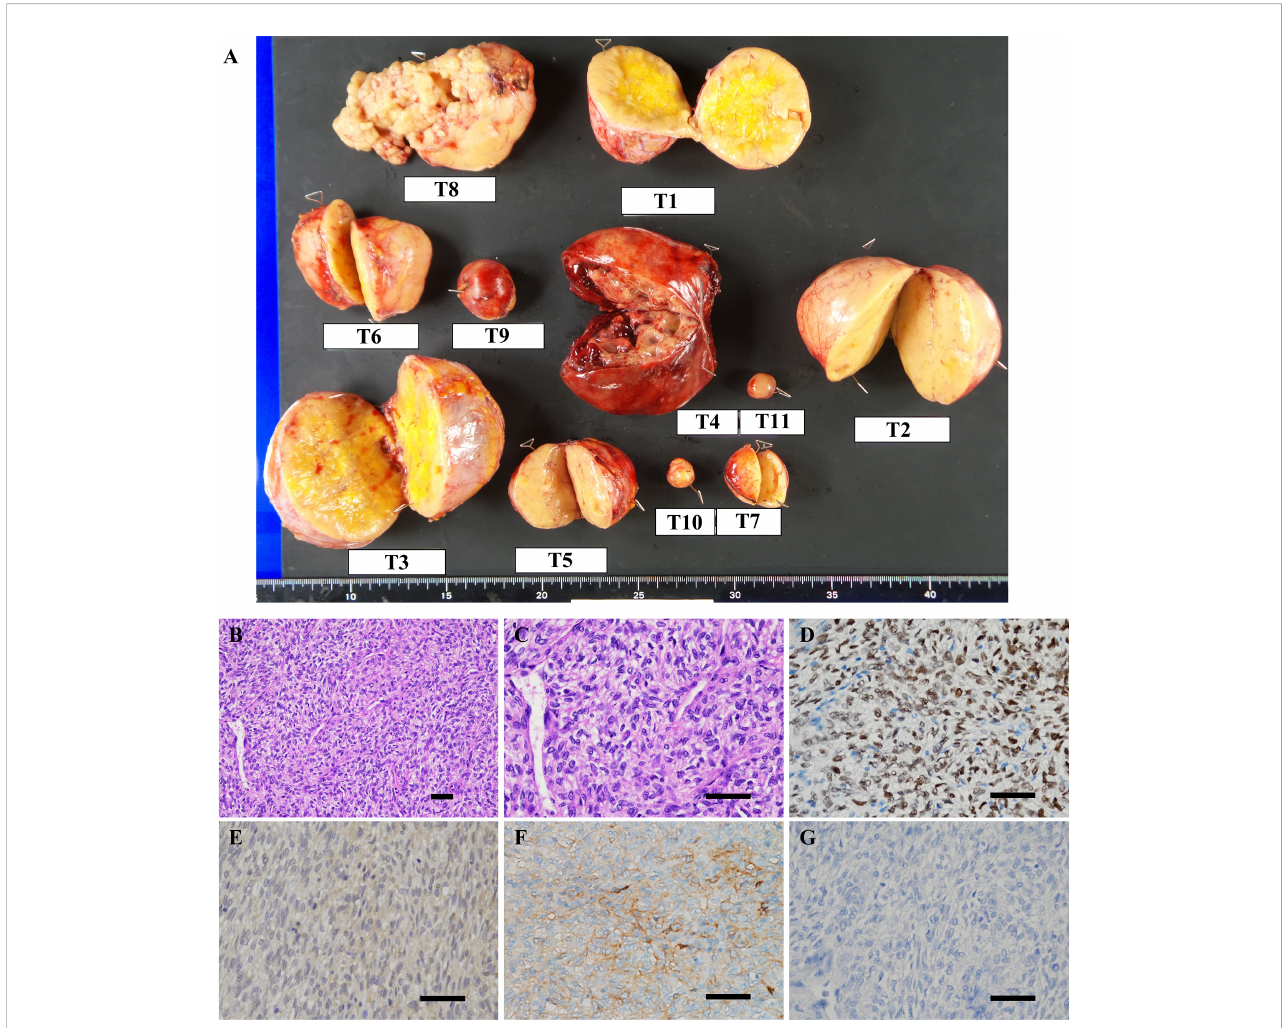
FIGURE 3 (A) Macroscopic view of resected tumors. T1 – 11 represent tumor #1 – 11. (B – G) Microscopic fi ndings of the representative resected tumor. (B, C) Hematoxylin and eosin staining showed that the tumor was composed of spindle to ovoid cells forming the patternless pattern. Immunohistochemical stains of tumor #10 show tumor cells to be positive for (D) signal transducer and activator of transcription 6 (STAT6), (E) IGF2, (F) somatostatin receptor 2 (SSTR2) and negative for (G) SSTR5. Scale bar: 50 m